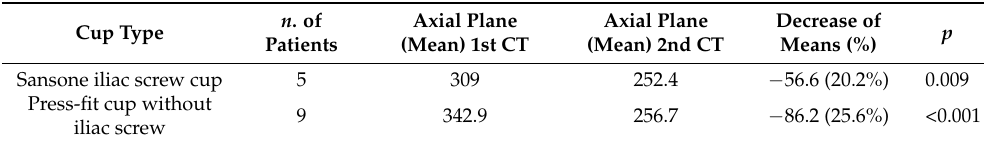
Table 10. Axial plane changes comparing 5–10 weeks with 12-month follow-ups in identified subgroups.